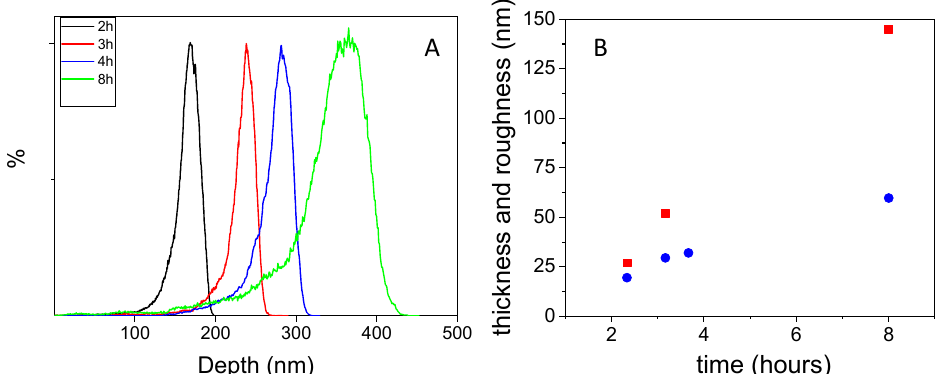
Figure 5. AFM characterization: ( A ) size of poly-L-DOPA aggregates as a function of time of polymerization; ( B ) roughness ( ■ ) and thickness ( ● ) of poly-L-DOPA coating as a function of polymerization time.